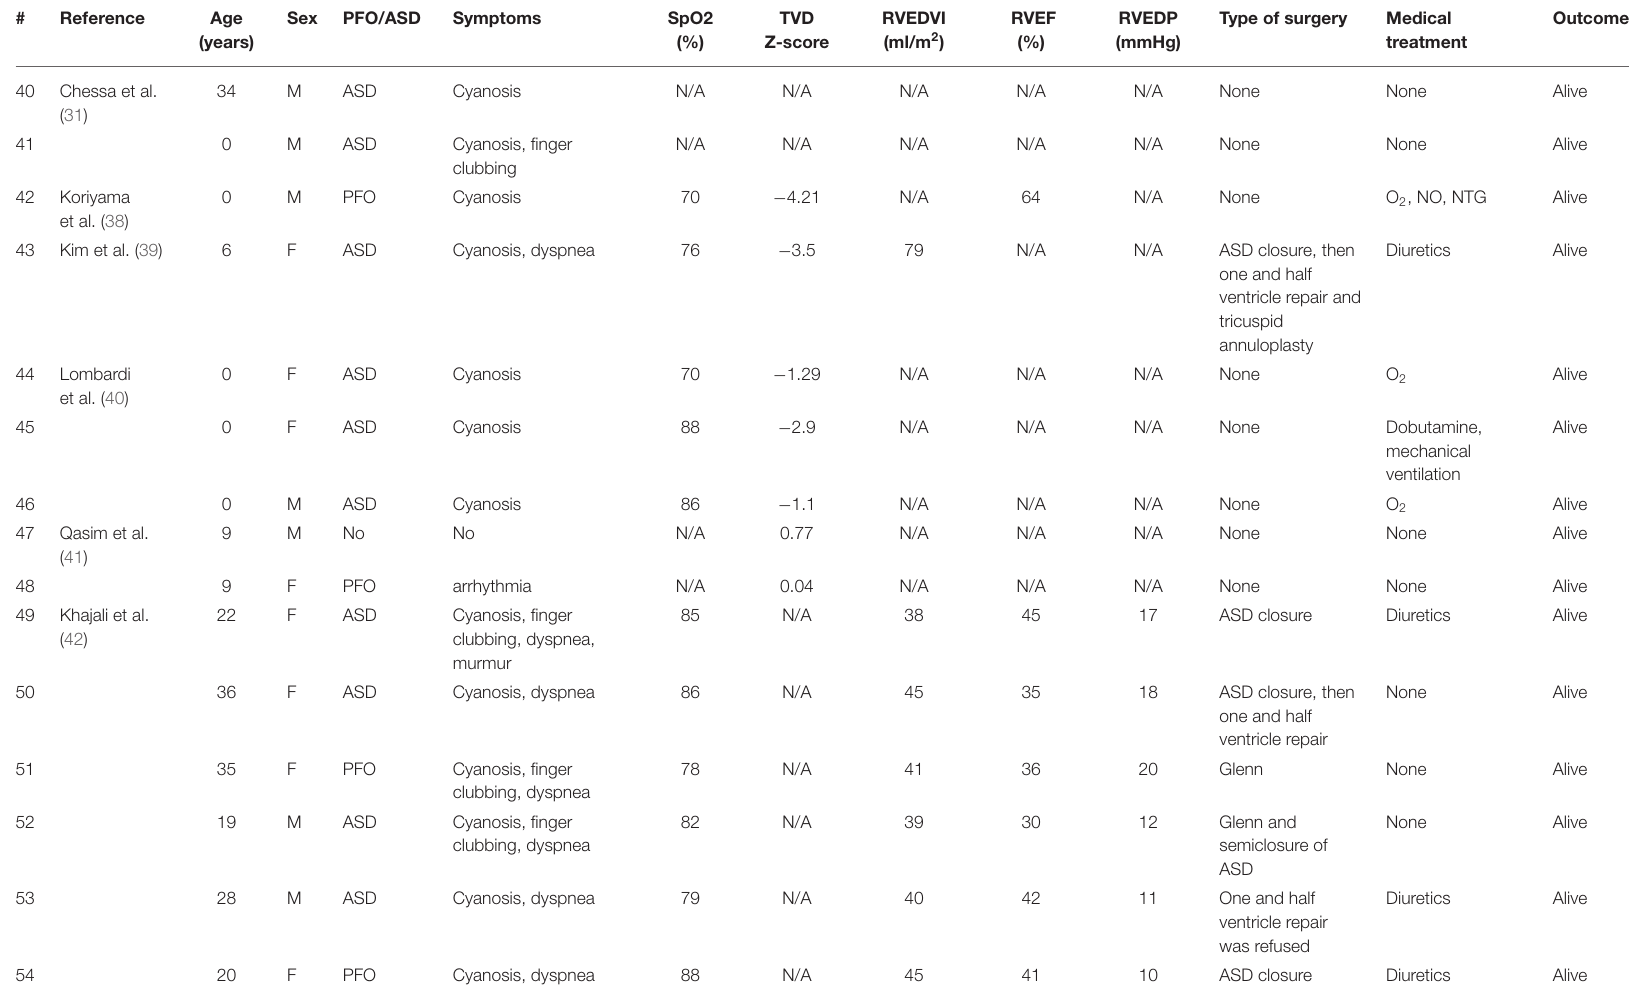
TABLE 3 | Summary of surgical and medical management of previous studies on patients with isolated right ventricular hypoplasia (from 2000 to